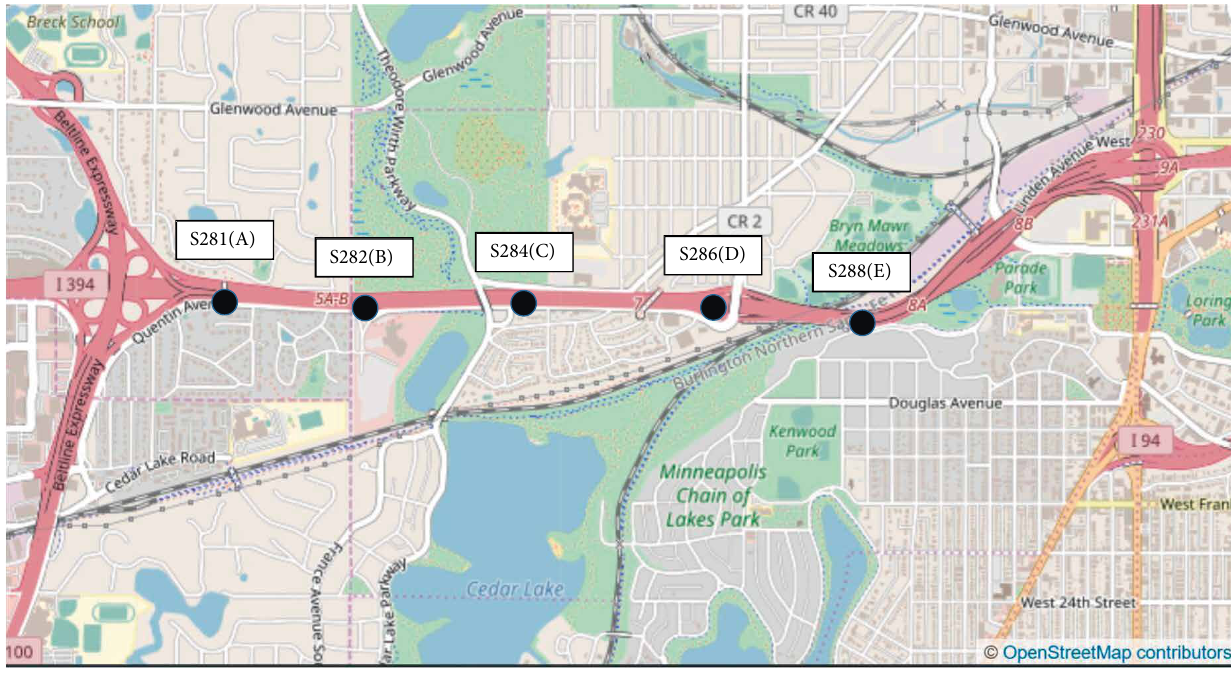
Figure 1: Location of I-394 road, from station A to station